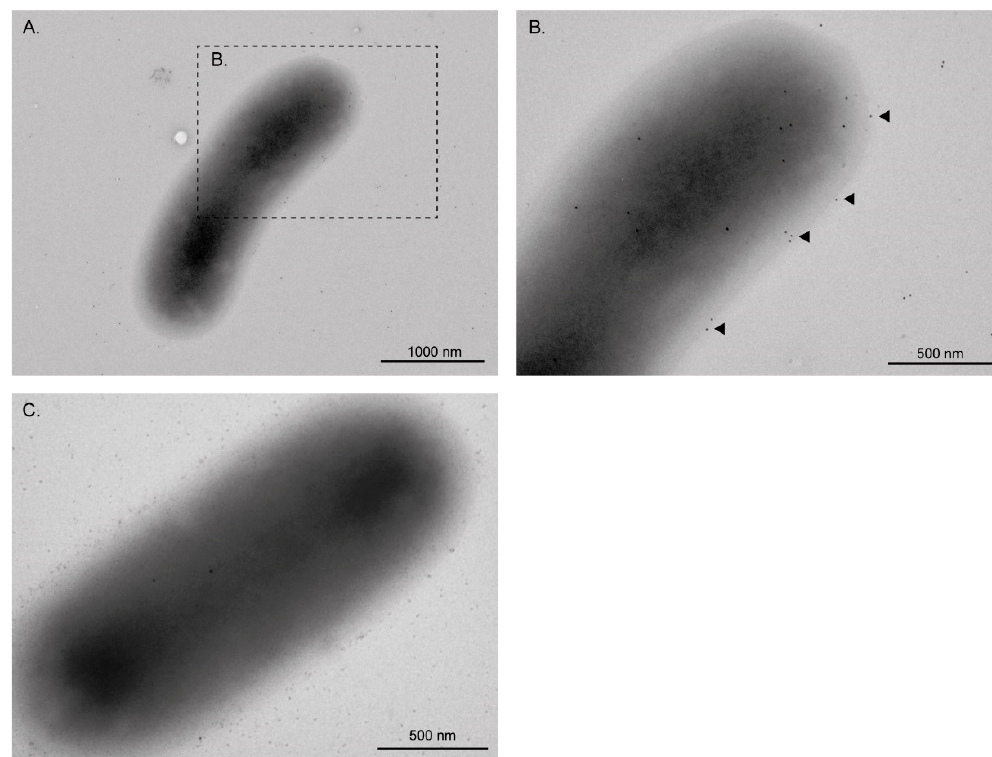
Figure 2. Immunogold electron microscopy showing detection of EF-Tu on the surface of STEC O157:H7 str. EDL933. ( A , B ) The localization of EF-Tu on the cell surface of EDL933 strain was demonstrated by abundant labeling with gold particles (Arrows). Bacteria were incubated with monoclonal anti-EF-Tu antibody (mAb 900; 1:200) followed by anti-mouse IgG+IgM (1:100) 10 nm gold particles. ( C ) As the control, the EDL933 strain was also incubated with anti-mouse IgG+IgM (1:100) gold particles. Note that in this case, a few gold labels were observed, but they appear to correspond to background noise rather than a specific detection.